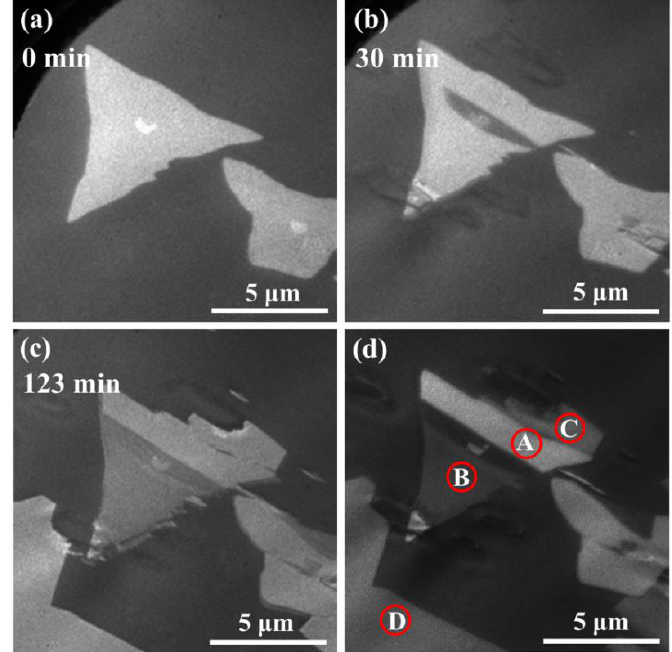
Figure 5. ( a-c ) LEEM images of graphene segregation processes on the surface covered by sub-monolayer h-BN. ( d ) UV-PEEM image of the surfaces. The labeled zones A, B, C and D represent pure h-BN, graphene segregated under h-BN, at the h-BN domain boundaries and on bared Ni zones, respectively.